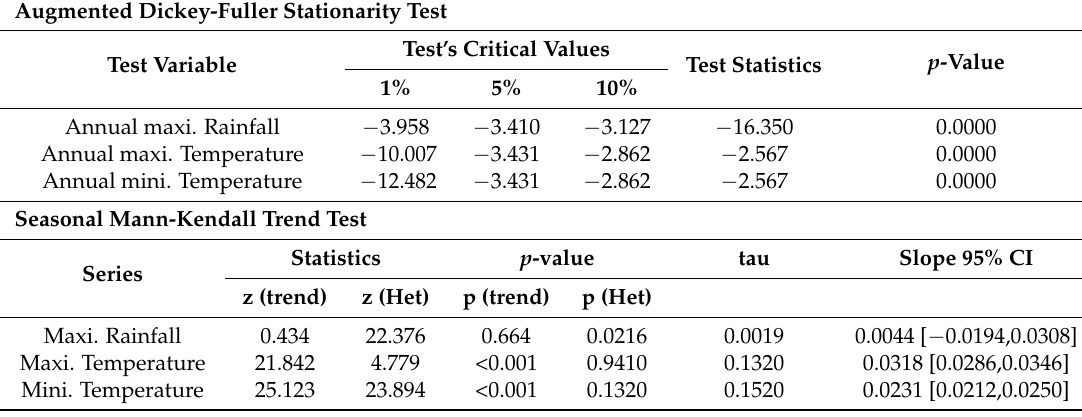
Table 4. Stationarity and Seasonality test.